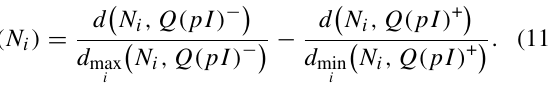
Algorithm 1 Input: the original linguistic decision matrices containing voting